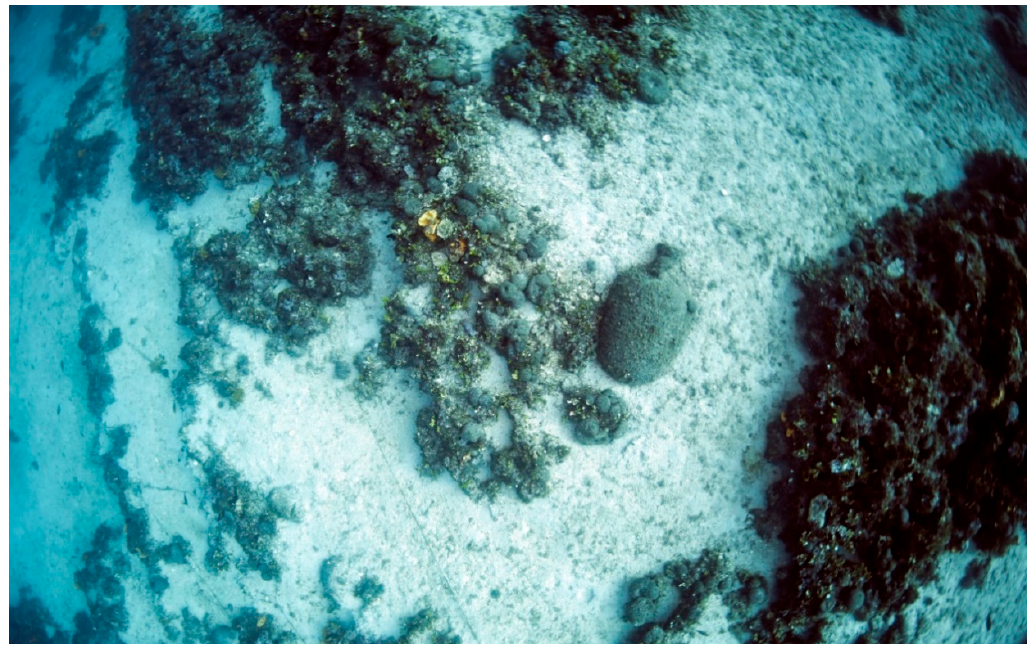
Figure 10. Detail of the accessible underwater archaeological site of “Telegrafos” shipwreck (Amaliapolis). ©MCS-EUA, photo by Matteo Collina, Università della